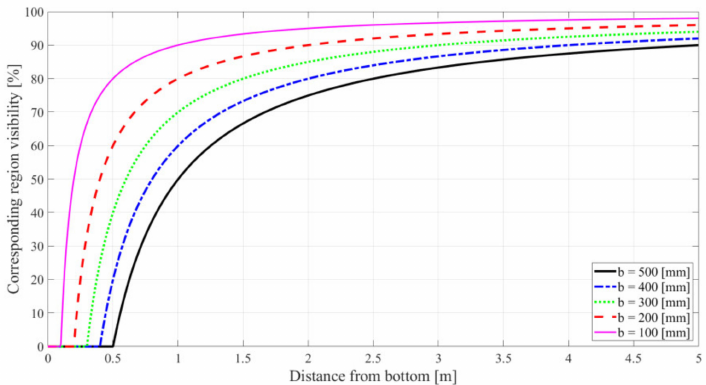
Figure 5. Corresponding region of visibility for different distances from bottom and baselines. The relation between the distance from the bottom and the region of visibility, occur- ring in consecutive frames of the left camera, delineating the vehicle’s various velocities, is presented in Figure 6.